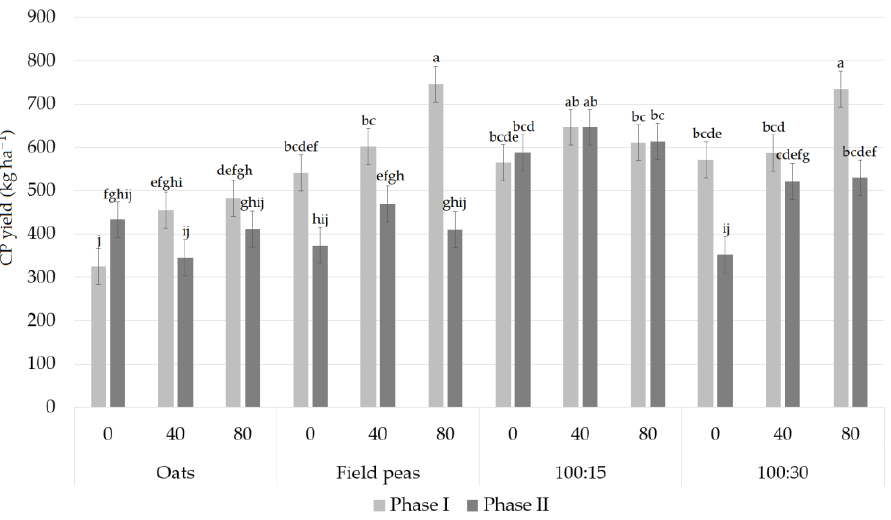
Figure 4. Crude protein yield of sole crops and their mixture under nitrogen fertilizer (0 kg ha −1 , 40 kg ha −1 , 80 kg ha −1 ) and two mowing phases (2016); error bars — standard error; a – j — significant differences between different treatments, a representing the highest value, etc.